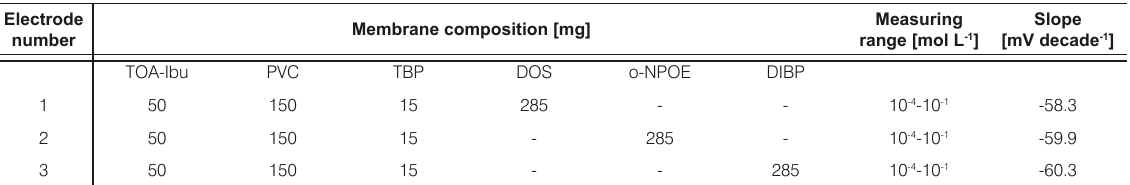
Table 1. Optimisation of membrane